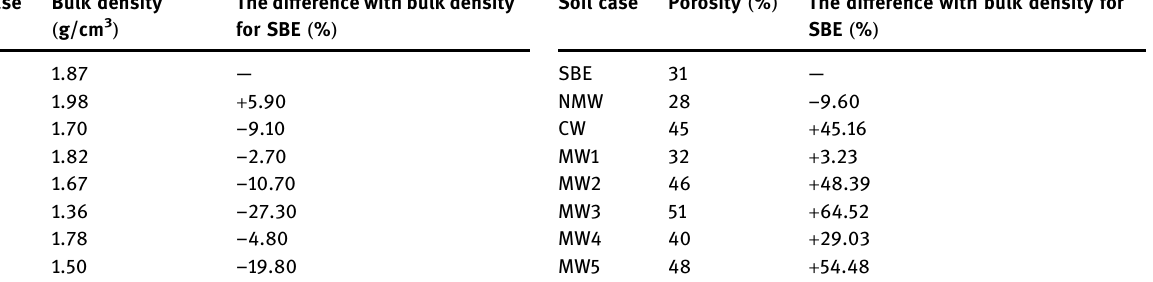
Table 4: The percentage of decrease and increase in the amount of bulk density of the soil Soil case